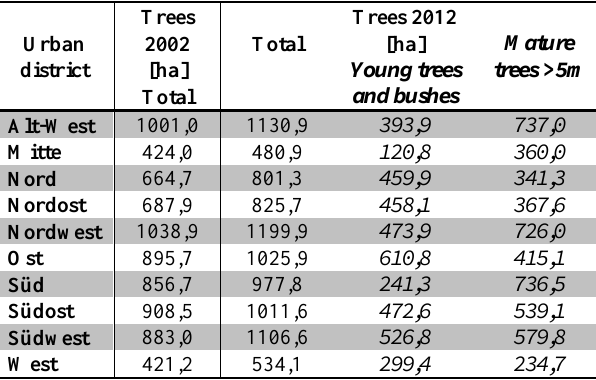
Table 2. Area covered by trees within the urban districts of the City of Leipzig for the years 2002 and 2012. In 2012 a further differentiation is undertaken for mature trees > 5m, and young trees and